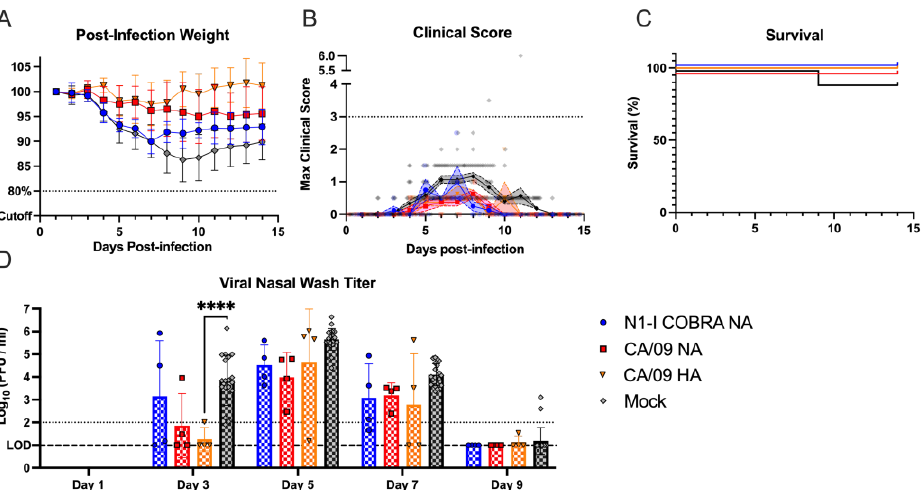
Figure 9. Vaccination of contact receiving ferrets did not limit transmission. ( A ) The weight during infection was normalized to the percentage of the original starting weight before co-housing on day 1 p.i. ( B ) The maximum clinical scores from the morning and evening checks were displayed with a score of three or greater indicating clinical endpoint. Individual ferret clinical scores are shown (lower opacity) with the line connecting the mean score (full opacity) and the standard error of the mean shaded. ( C ) The survival percentage for each group was determined. ( D ) The nasal wash titers for all vaccinated groups were determined through plaque assay. The limit of detection (LOD; dashed line) was 1.0 log 10 (PFU/mL), and the limit of quantification (dotted line) was 2.0 log 10 (PFU/mL). Mixed effects analysis with repeated measures was used for statistical analysis. Tukey’s test for multiple comparisons was used for the weight analysis, and Dunnett’s test was used for nasal wash titers with the mock receivers as the control group. All error bars represent standard deviation. The minimum weight before clinical endpoint was 75%, with 80% denoting an increase in clinical scoring. Adjusted p -value: **** ≤ 0.0001.